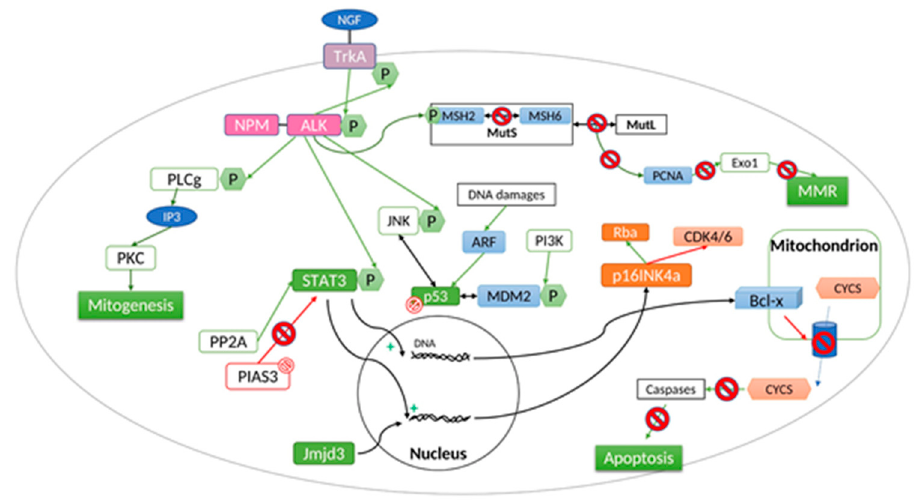
Figure 2. ALK-independent resistance mechanism.